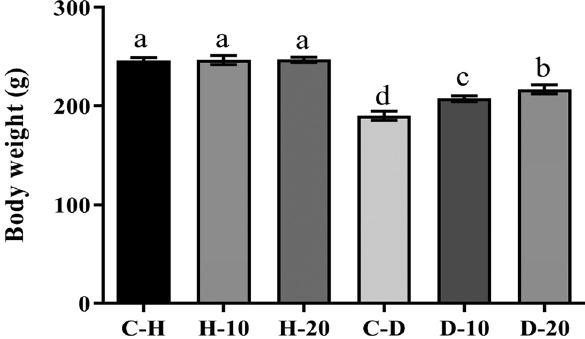
Figure 1: E ff ects of daily administration of NOM on body weight ( g ) in diabetic and non - diabetic rats. Di ff erent superscripts ( a – d ) show signi fi cant di ff erences between the groups. The results did not show signi fi cant di ff erences between healthy animals. The administration of the NOM increased the body weight compared with diabetic control in diabetic groups. C – H, H - 10 and H - 20 are healthy rats receiving 0, 10 and 20 mg/kg NOM, while C – D, D - 10 and D - 20 are diabetic rats receiving 0, 10 and 20 mg/kg